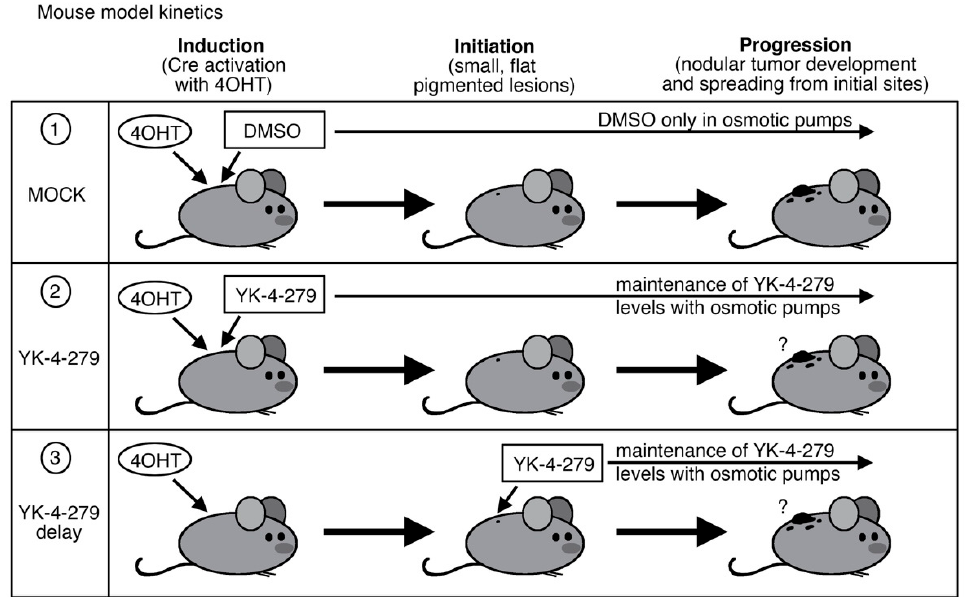
Figure 1. Schematic for study design. For all treatment groups, mice were induced with 4-hydroxy tamoxifen (4-OHT) on day one of the study. Row ( 1 ), MOCK control group, was treated with DMSO; row ( 2 ), YK-4-279 group, was treated with YK-4-279 on day 1; and row ( 3 ), YK-4-279 delay group, was treated two weeks after induction and initiation. For each group, mice had osmotic pumps surgically implanted in the intraperitoneal space with the drug or DMSO. For all mice, disease benchmarks of the first observation of a pigmented lesion (initiation) and progression to a palpable lesion (progression) were recorded.